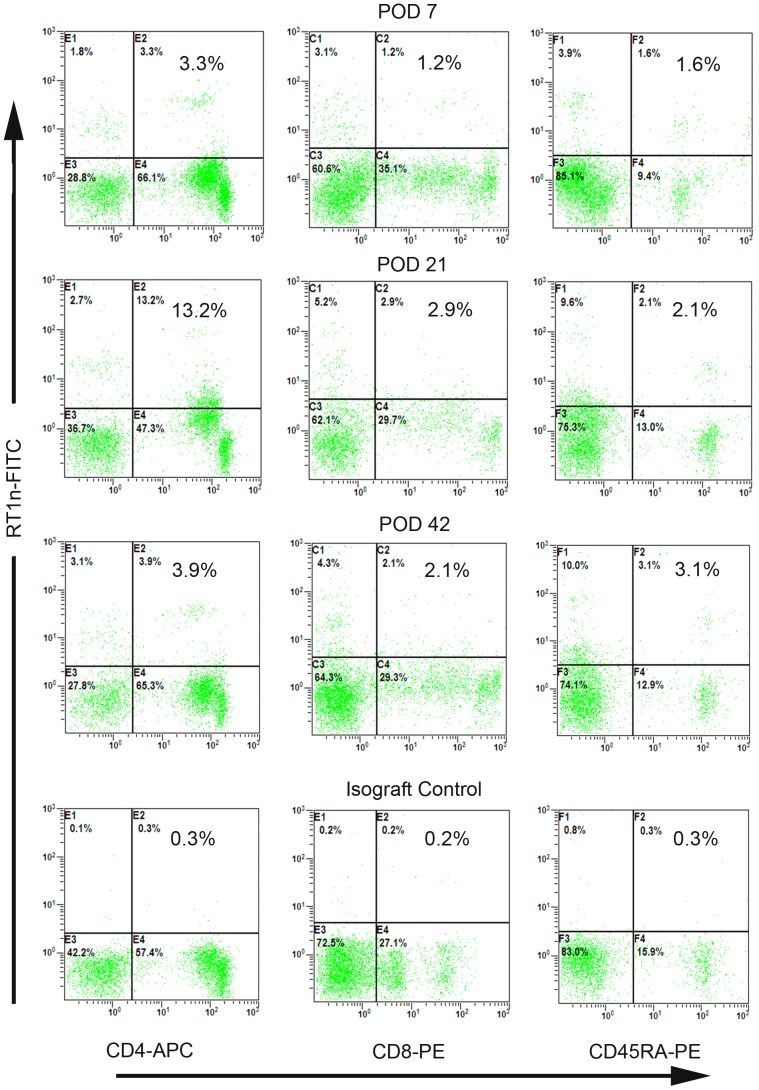
Dynamic changes in peripheral and myeloid chimerism.(a) Time kinetics of chimerism in groups 5 and 6. At POD 7, they showed almost the same chimerism level (P>0.05). At POD 21, the level of chimerism in group 6 was mildly decreased, but it increased sharply in group 5 (P<0.05). At POD 42, chimerism in group 5 returned to a total level 8.7%±0.6% but it decreased to background level in group 6 (P<0.05). In addition, donor-origin CD45RA+ B cells in group 5 prevailed beginning at POD 21 and maintained thereafter. (b) Myeloid chimerism was detectable at 6.3±0.5% at POD 100 in group 5 and it never appeared in group 6 when allografts were rejected (n = 6, P<0.05).